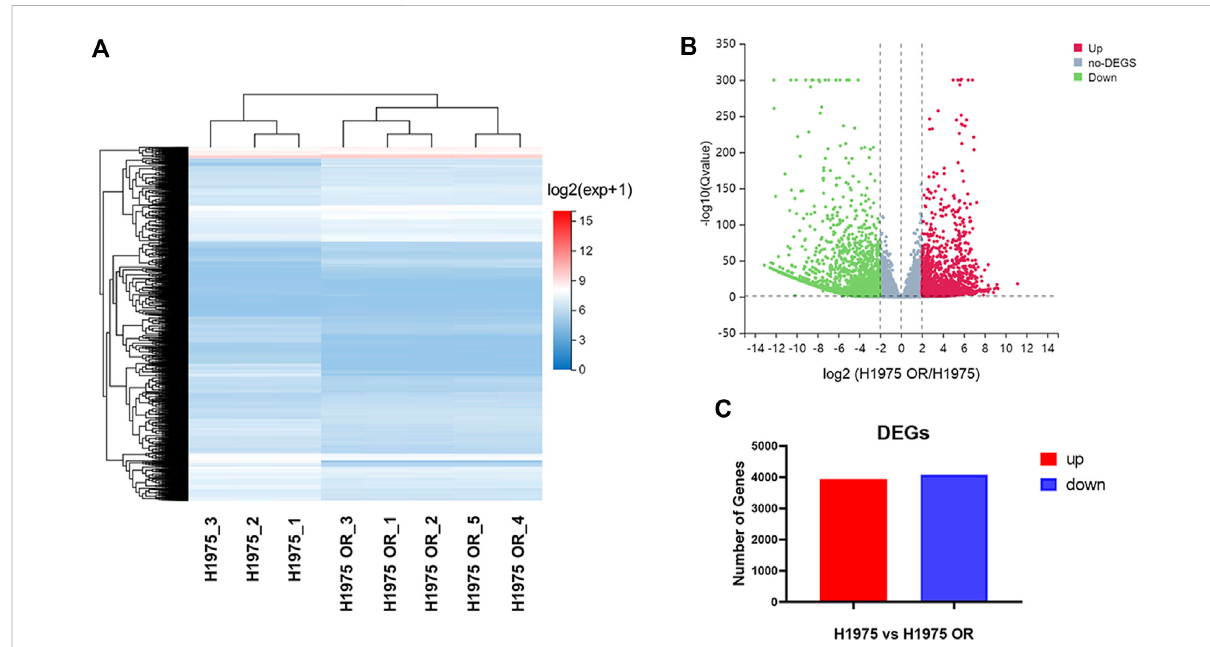
FIGURE 2 RNA-seq identi fi ed the DEGs in OSI-resistant NSCLC cells. (A) The cluster heatmap shows the expression of DEGs between H1975 cells and H1975ORcellsdetectedbyRNA-seq. (B) Thevolcanoplotexhibitstheup-regulatedDEGs,no-DEGs,anddownregulatedDEGsbetweenH1975cells and H1975 OR cells. (C) The graph shows the number of up-regulated and down-regulated differentially expressed gene transcripts in H1975 OR cells compared to H1975